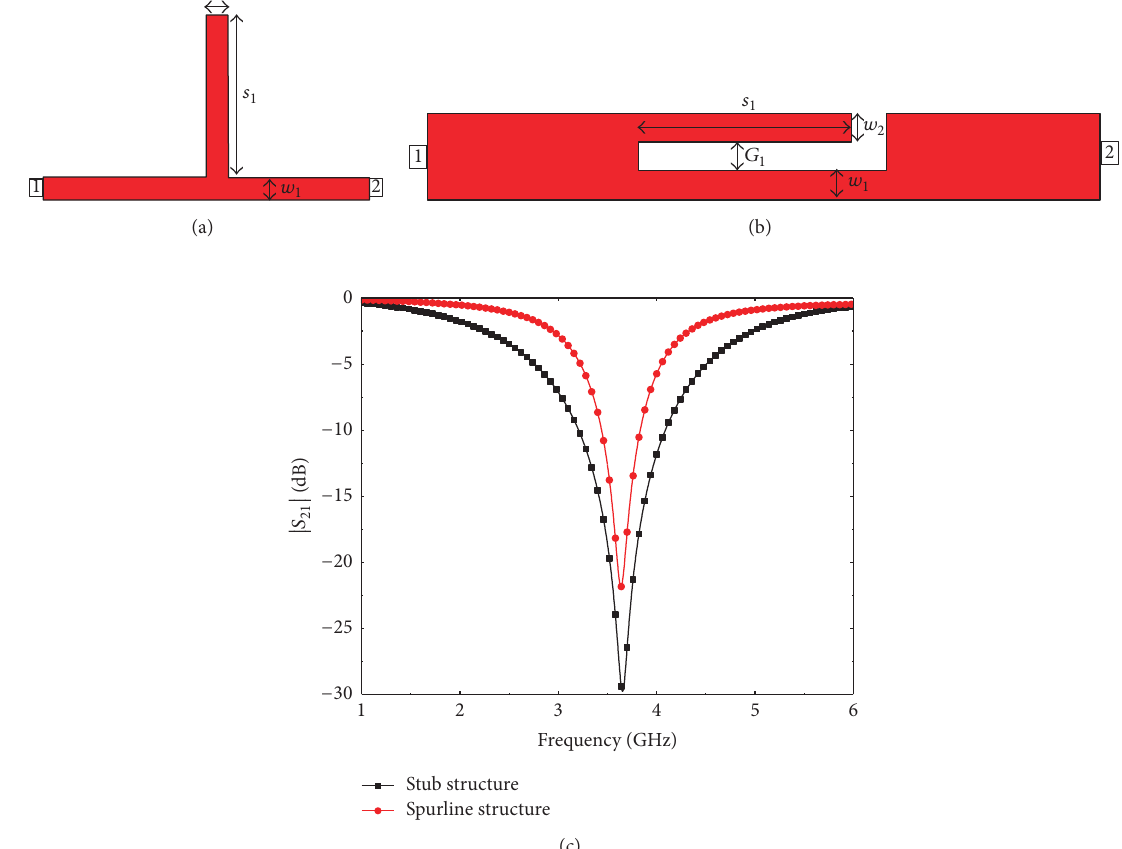
Figure 3: (a) One-stub structure, (b) spurline structure, and (c) their transmission properties for 𝑤 1 = 𝑤 2 = 0.276 mm and 𝐺 1 = 0.05 mm.